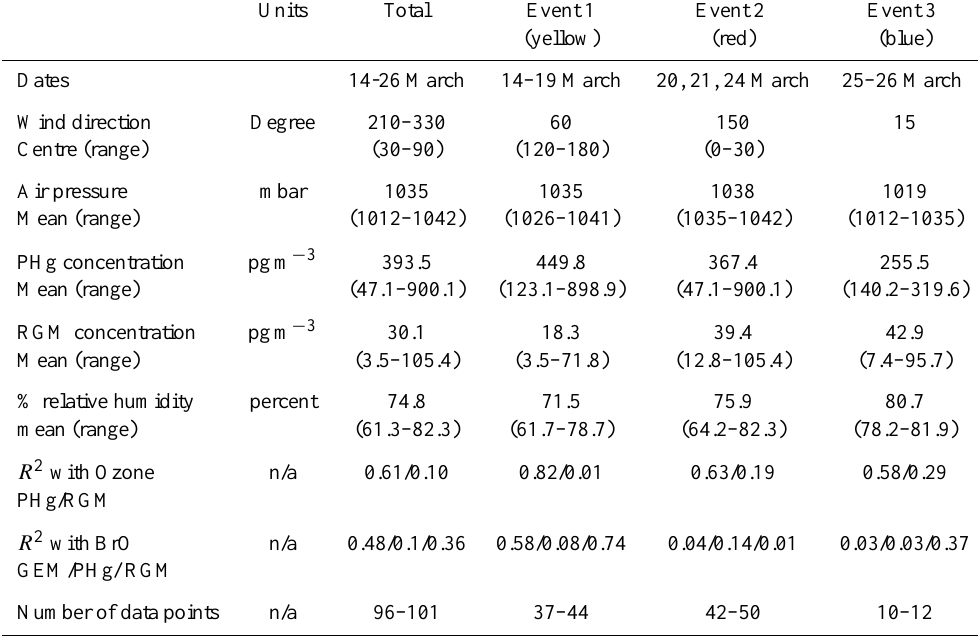
Table 2. Summary information for data collected over the sea ice for the total study period and events 1, 2 and